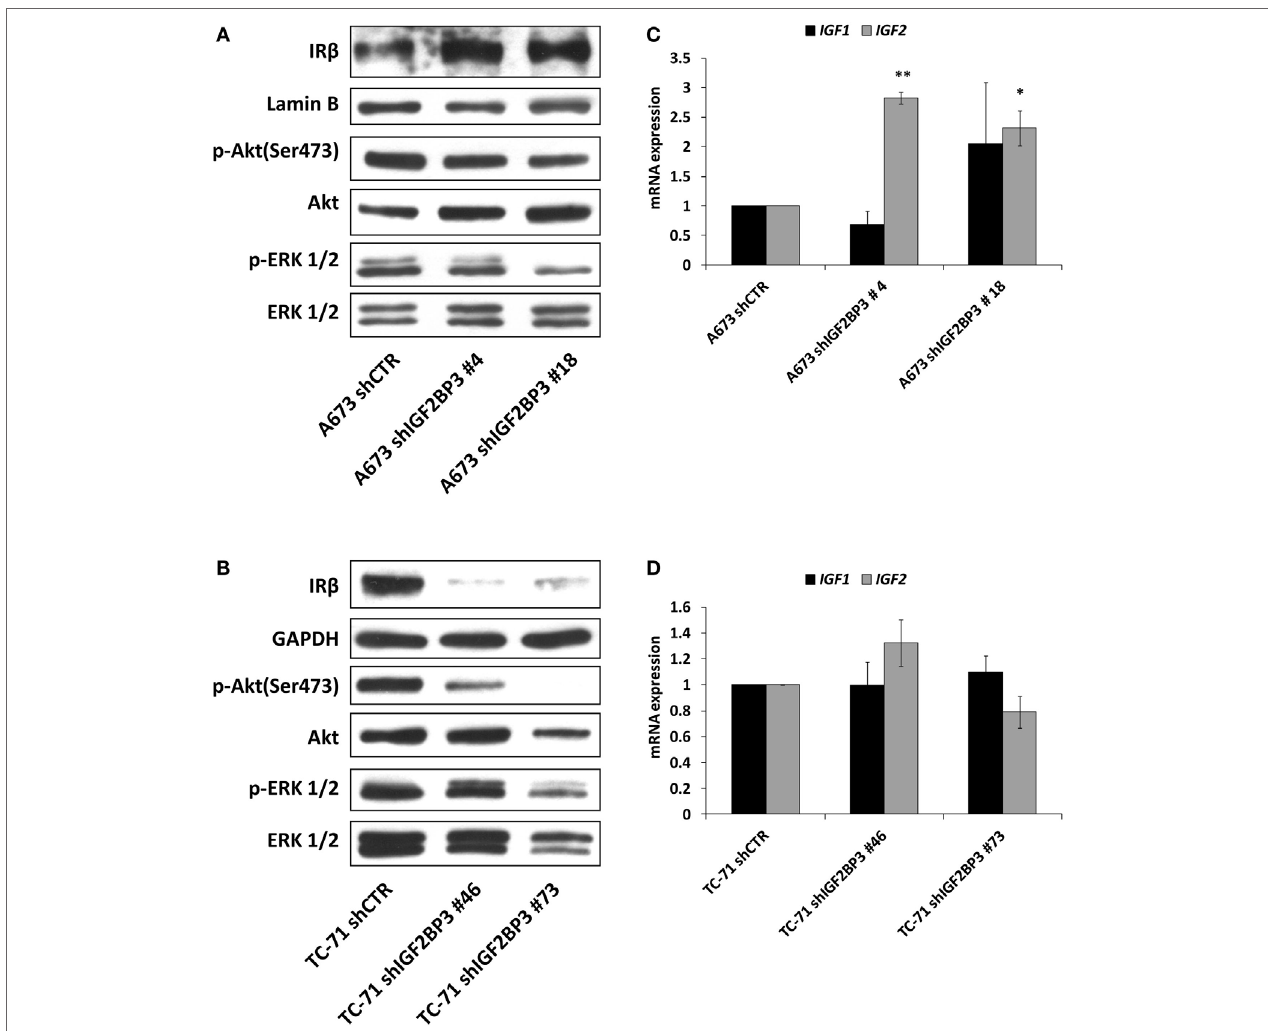
FigUre 4 | Insulin receptor (IR) signaling in response to insulin-like growth factor 2 (IGF2) mRNA-binding protein 3 (IGF2BP3)-mediated IGF1R regulation. (a,B) Western blotting depicting the expression of IR and phosphorylation of Akt and ERK 1/2 in IGF2BP3-depleted or empty vector-transfected (shCTR) (a) A673 or (B) TC-71 Ewing sarcoma (ES) cells. GAPDH, Lamin B, and total proteins were used for normalization purposes. Data from one experiment representative of three. (c,D) mRNA level of IGF1 and IGF2 , expressed as 2 −ΔΔ Ct , in IGF2BP3-depleted or empty vector-transfected (shCTR) (c) A673 or (D) TC-71 cells. Columns represent the mean values of at least two independent experiments, in which samples were run in triplicates, and the bars represent the SE. * p < 0.05, ** p < 0.01, one-way ANOVA compared with